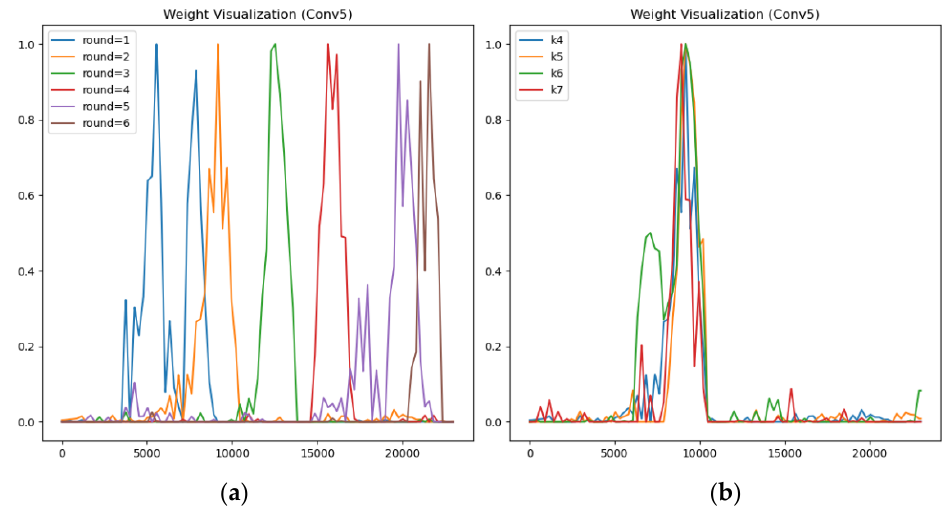
Figure 7. The result of weight visualization, they should be listed as: ( a ) shows the same byte posi- tion of extension keys with different rounds, and ( b ) shows the different byte position of extension key with same round.